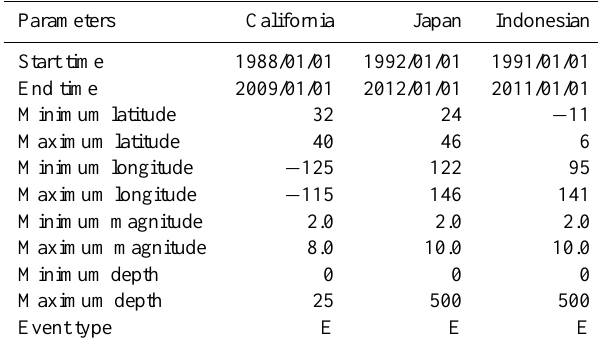
Table 3. List of parameters used to acquire the California, Japan and Indonesian catalogs (ANSS, 2012).